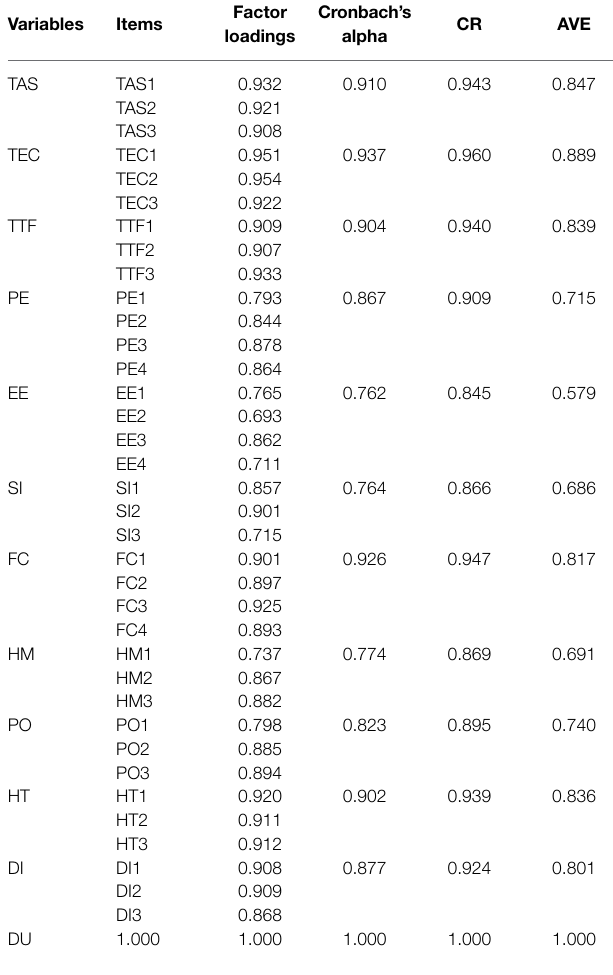
TABLE 3 | Confirmatory factor analysis